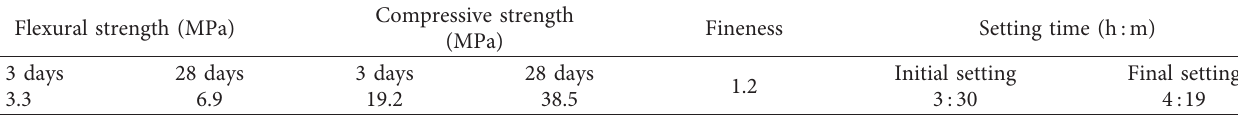
Table 1: Mechanical properties of Portland cement (MPa).